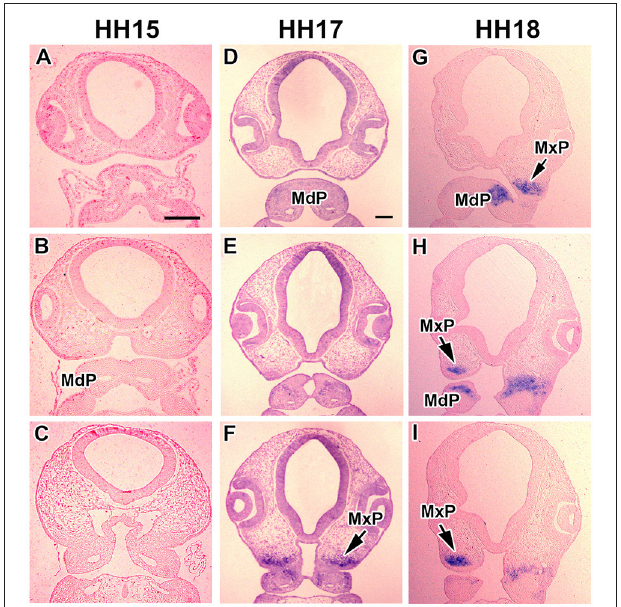
FIGURE 2 | Gene expression of MORN5 in early chicken face. (A–C) Frontal sections of chicken face at stage HH15. (D–F) Frontal sections of chicken face at stage 17. (D,E) In the ventral part of maxillary and mandibular prominences, there was no expression. (F) MORN5 expression gradually appeared dorsally in caudal part of maxillary region. (G–I) Frontal sections of chicken face at stage HH18. MORN5 expression was strong in maxilla and also in central part of each mandibular prominence (G) . MdP, mandibular prominence; MxP, maxillary prominence. Scale bars = 100 µ